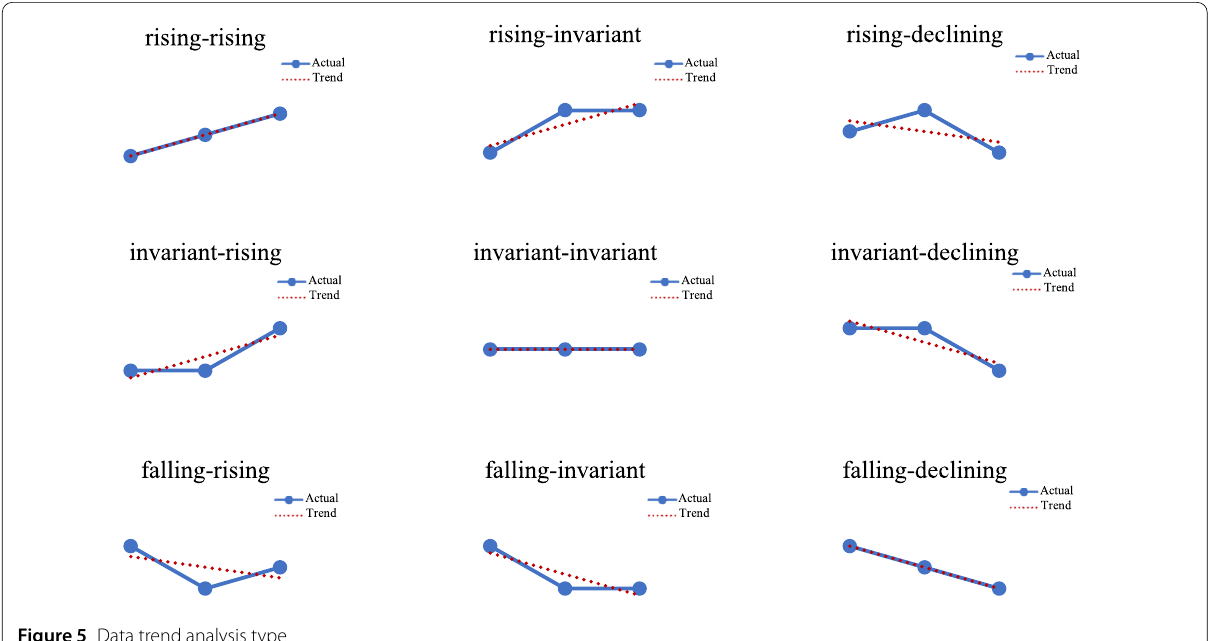
Figure 5 Data trend analysis